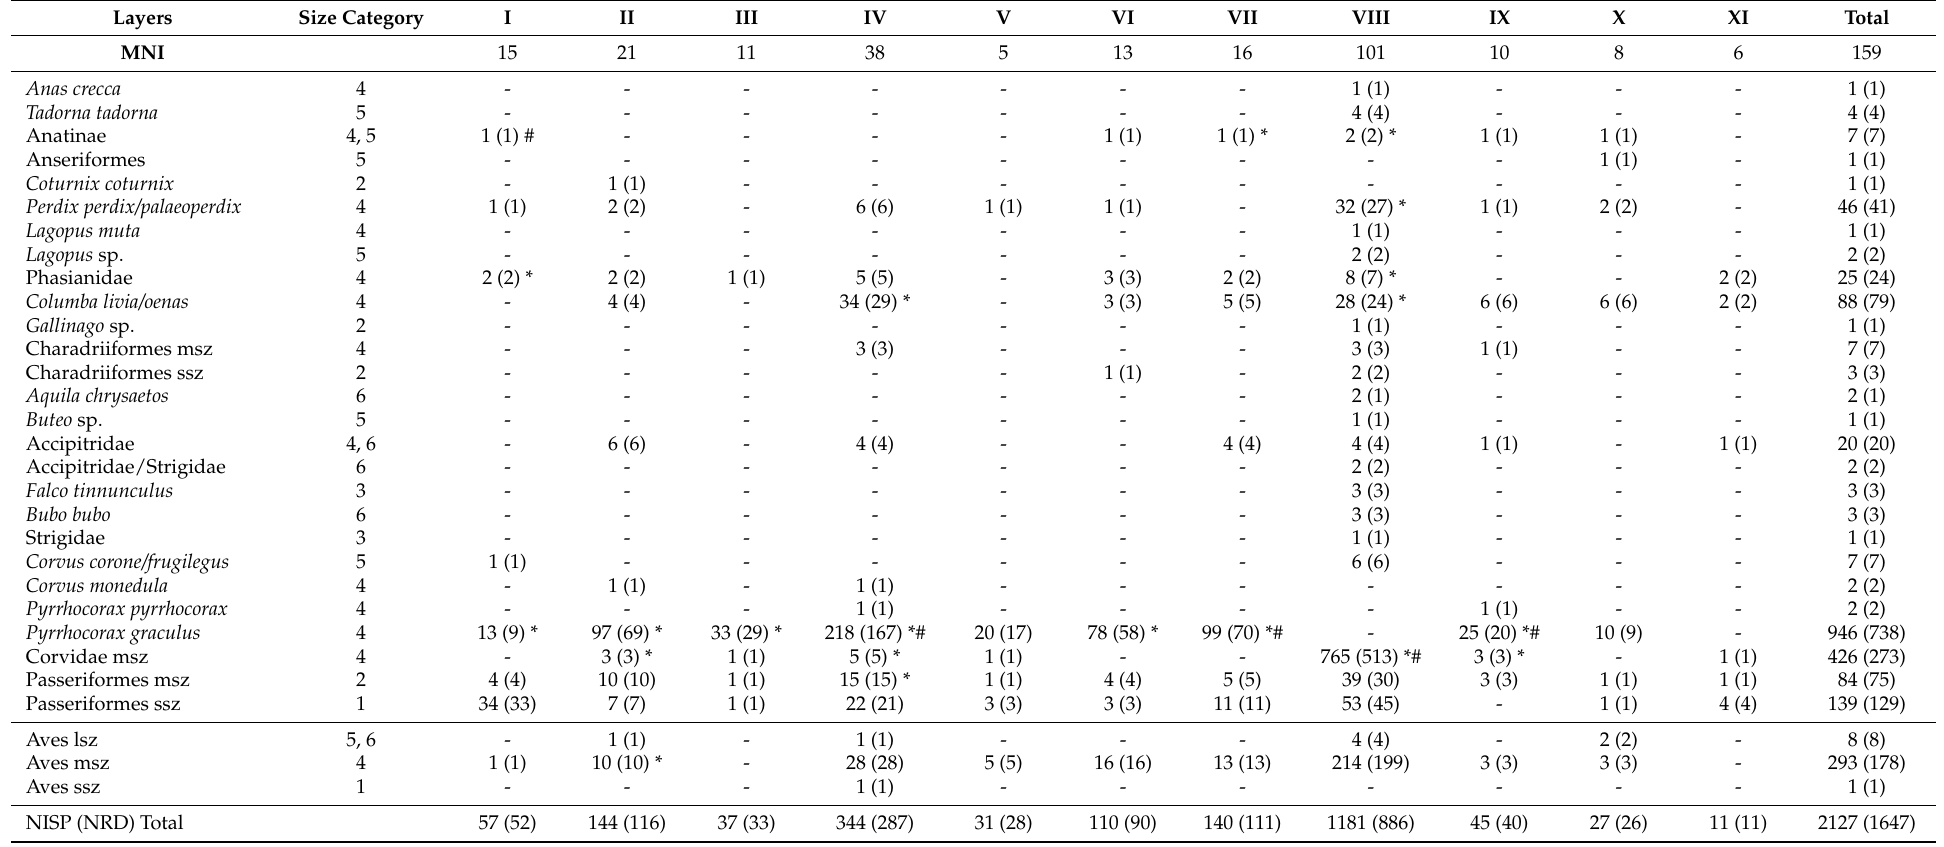
Table A1. Synthetic table with the NISP, MNE, and MNI for each archaeological layer of Grotte Vaufrey. NISP (MNE); * = presence of immatures; # = presence of females (medullary bone). Lsz: large size; msz: medium size; ssz: small size. NRD: number of remains determined. The classification by size has been included considering six categories according to bird’s